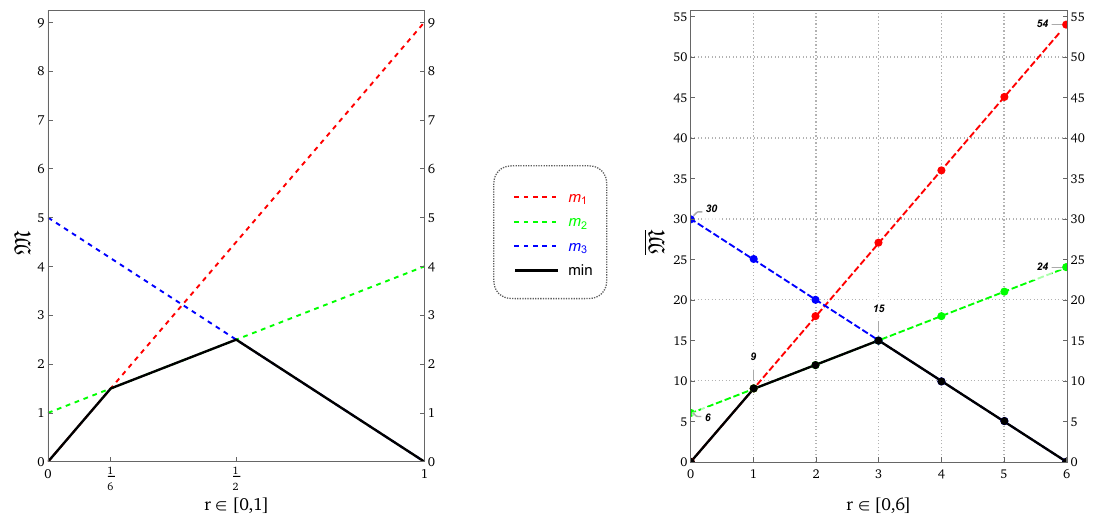
¯ M defined by (D.29) for k = 1 and 6 , respectively, in Figure 6 . The minimum functions M and their domains I : [0 , 1] and ¯ I : [0 , k ] . Sketched in the left figure is for an example configuration where a specific triple of linear functions L , m = m , determine the minimum function M globally, m 1 , 2 , 3 and hence, N = 3 , with the corresponding two-vectors ( (cid:15) ) = (0 , 9) , (1 , 4) and (5 , 0) , which p,m , (cid:15) p +1 ,m indicates that (cid:15) (0) = 5 and (cid:15) (1) = 9 ; the dashed lines in red, green and blue are for the triple L p p m 1 , 2 , 3 and the solid black line is for their minimum M . Note that R = 1 and R = 1 so that their 1 2 6 2 denominators Q and Q determine k ( p ) as lcm( Q ) = lcm(6 , 2) = 6 , which is taken as the value 1 2 1 , Q 2 0 of k for the right figure; the analogous objects defined for the base-changed configuration with k = 6 are depicted on the